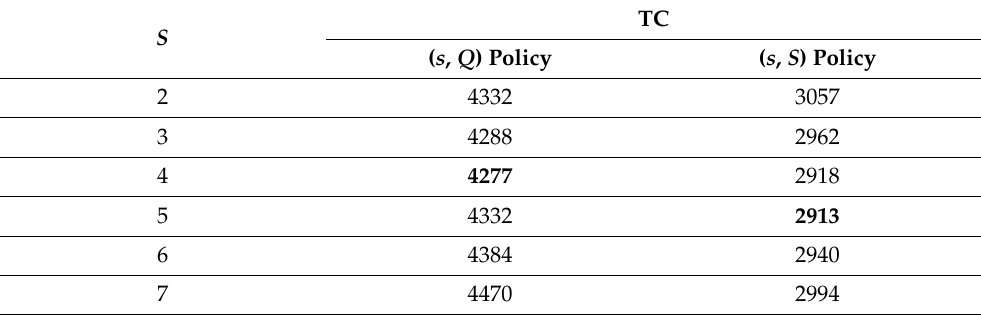
Table 8. Results of the optimization problem; the optimal (minimal) value of the TC is indicated in bold